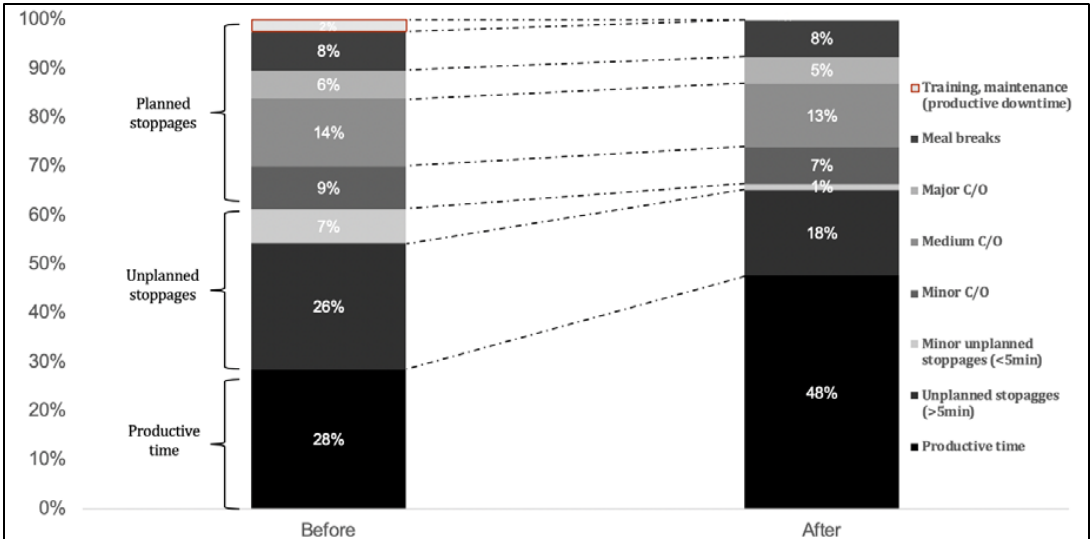
Figure 3. OAE Loss